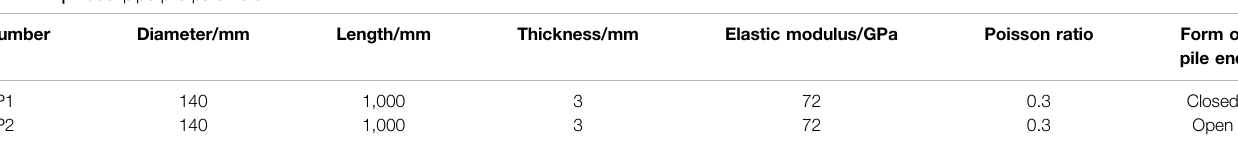
TABLE 1 | Model pipe pile